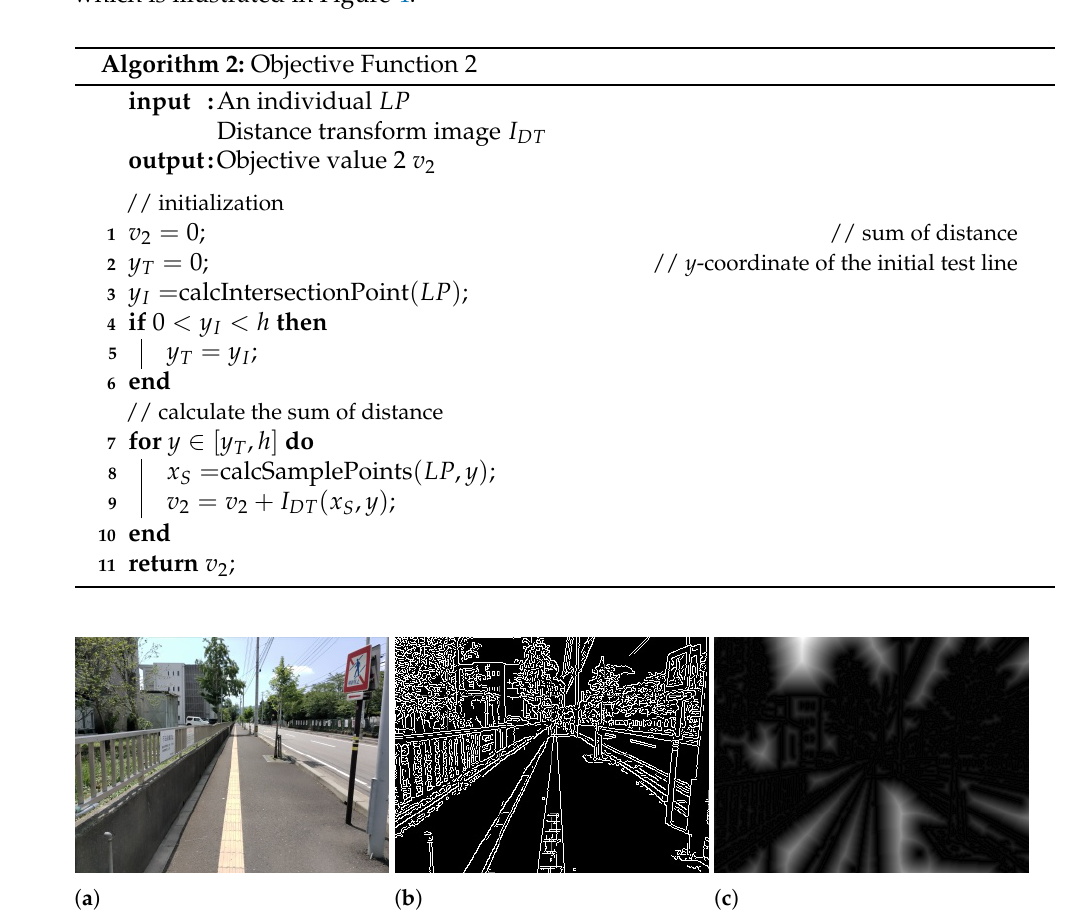
Figure 5. ( a ) Input image, ( b ) Edge image, ( c ) Distance transform